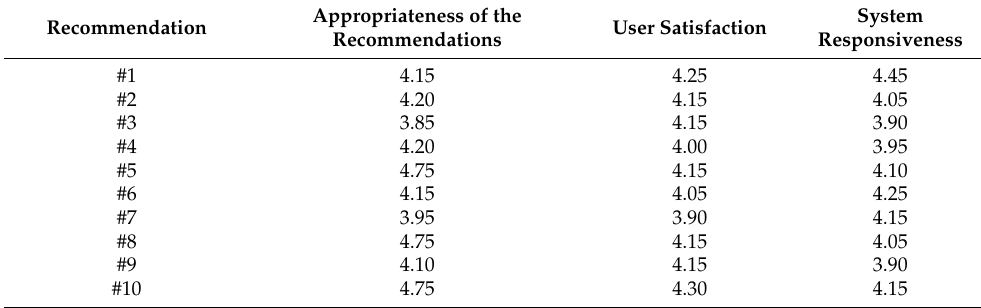
Table 5. Results of the Testing phase across all participants (average